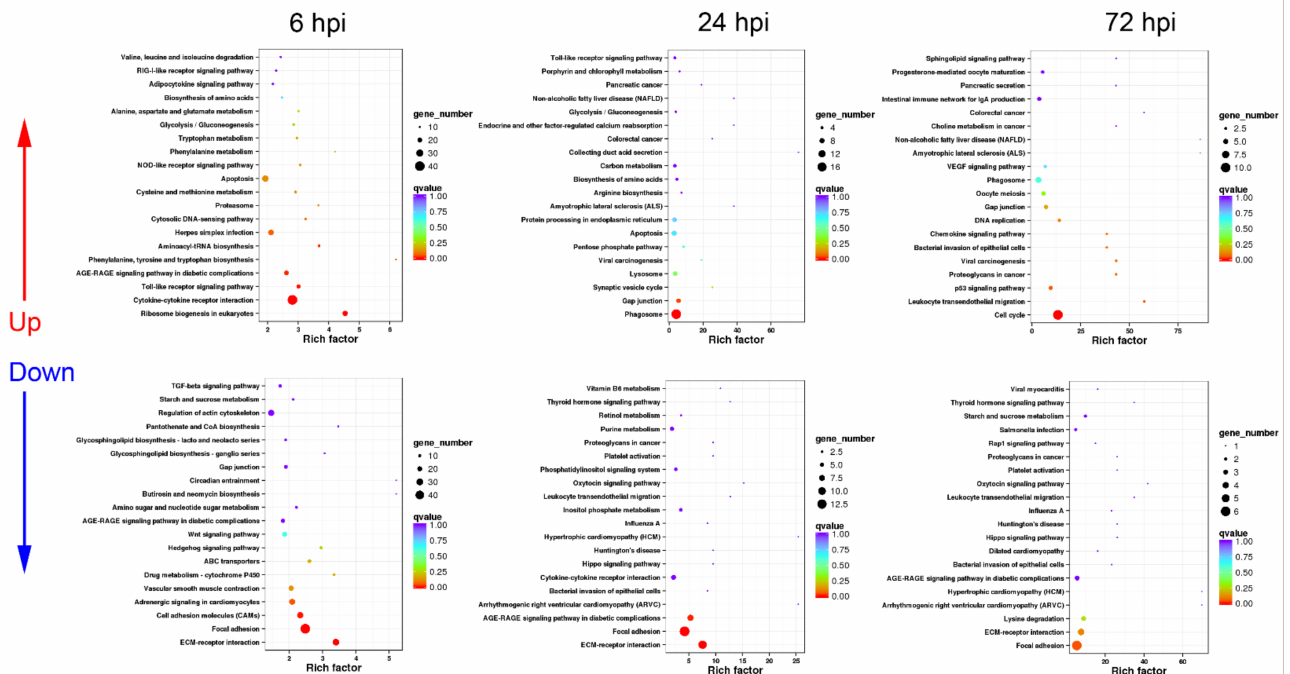
Figure 6. KEGG enrichment analysis in IS group turtles at different time periods. The top 20 KEGG pathways are presented here in the form of scatterplots to show the up-regulated and down-regulated DEGs enriched in spleens from inactive subgroup turtles at 6, 12, and 72 hpi. The enrichment factor is the ratio between the DEG number and the number of all genes in a certain gene enrichment term. The sizes of the dots on these plots denote the number of DEGs, while colors correspond to the q value